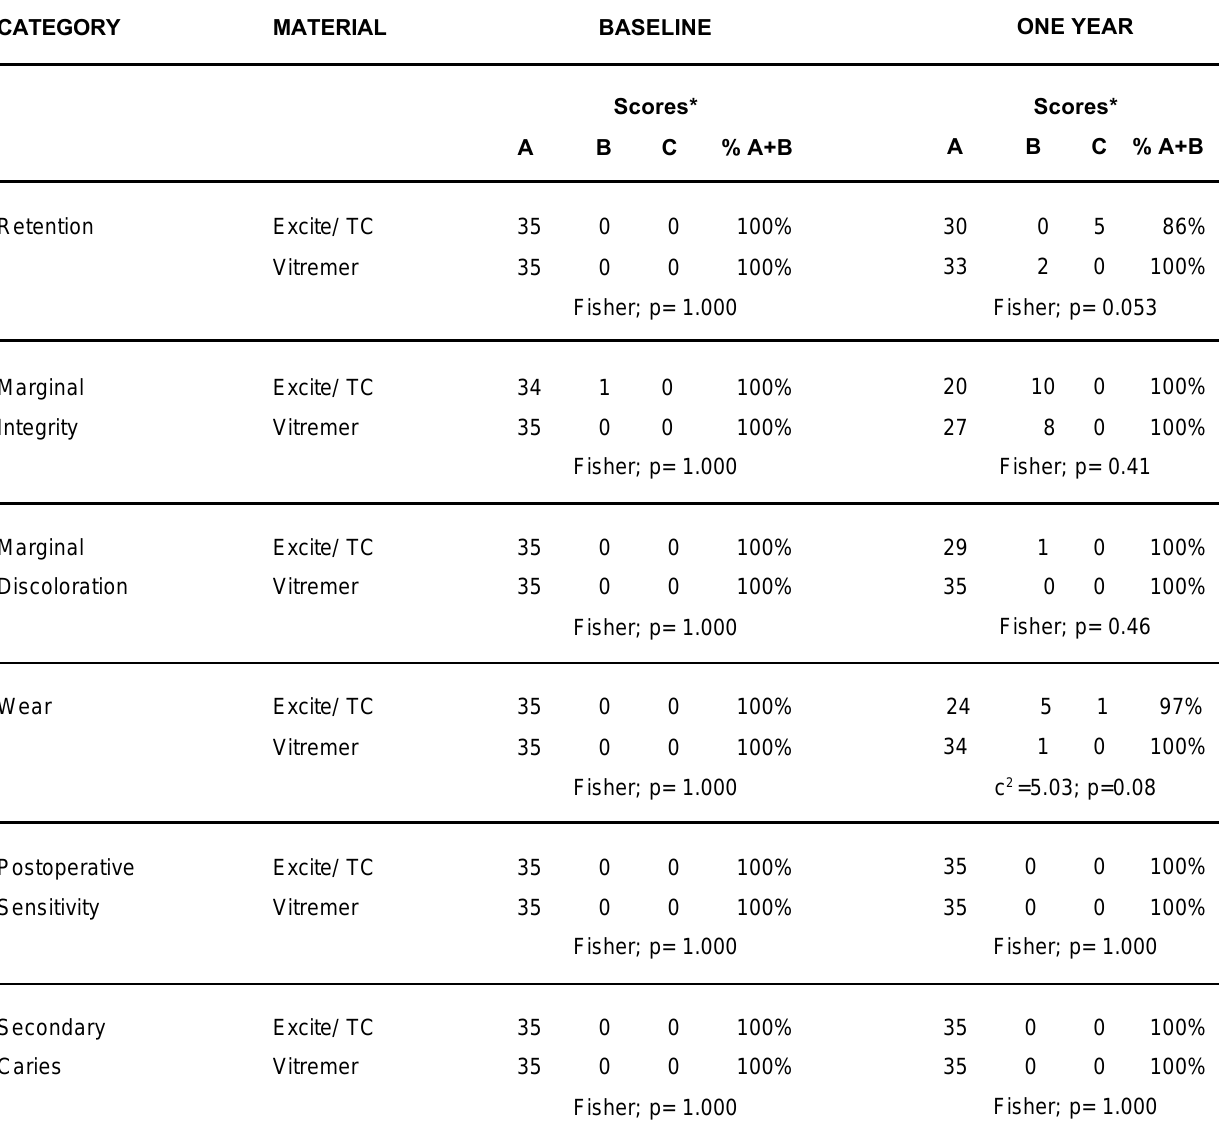
TABLE 2- Evaluation of the materials at baseline and after one